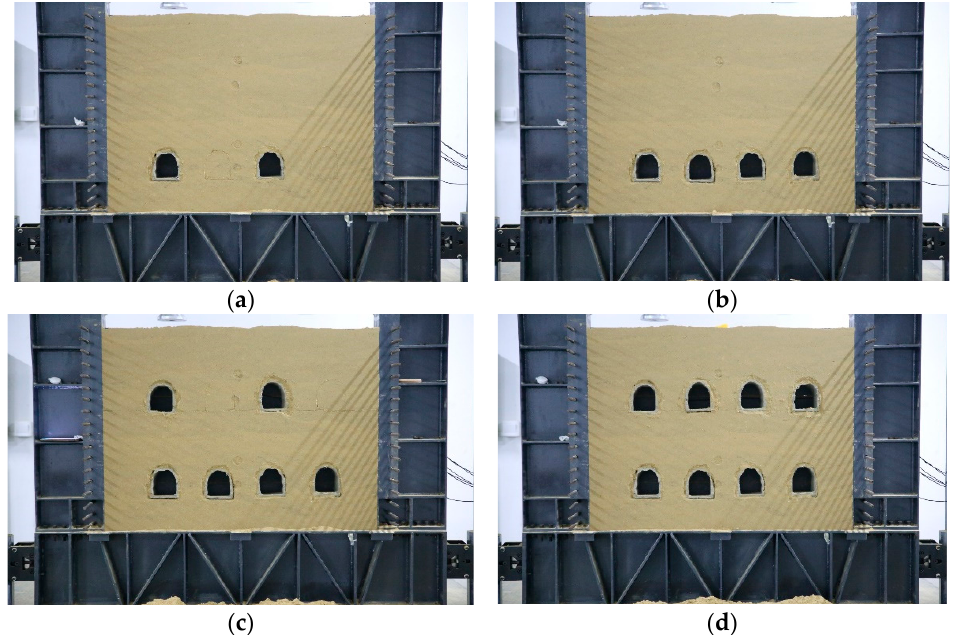
Figure 15. Excavation of the pilot tunnels: ( a ) 5-7; ( b ) 5-7-6-8; ( c ) 5-7-6-8-1-3 and ( d ) 5-7-6-8-1-3-4-2. Figure 16 gives the stress increments of the four monitoring points, with the abscissa representing the number of stress-monitoring points in this figure. As seen in this figure, when all pilot tunnels are excavated, the vertical stresses at monitoring points 1 and 4 are reduced to 6.49 kPa and 0.53 kPa, respectively, but at monitoring points 2 and 3, there are increases to 3.62 kPa and 4.00 kPa, respectively. This situation is largely consistent with the results of the numerical simulation, where the peaks are mainly distributed both at the tops of the pilot tunnels and between the bottoms of tunnels and where valleys are mainly distributed both at the bottoms of pilot tunnels and between the tops of tunnels.